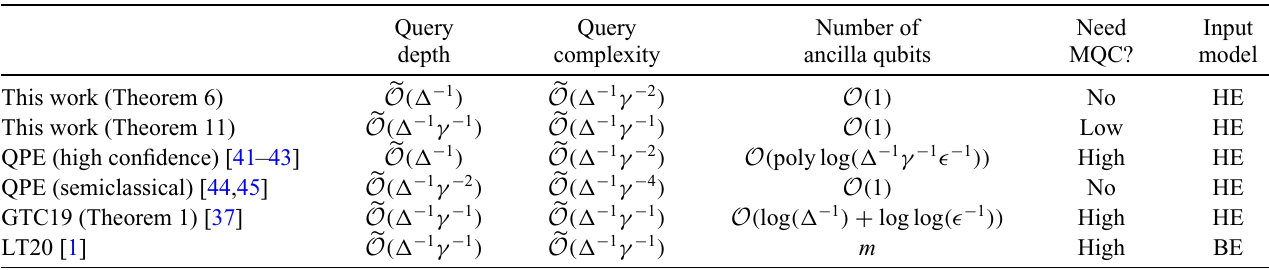
TABLE II. A comparison of the performance of quantum algorithms for ground-state preparation in terms of the query complexity, the query depth, the number of ancilla qubits, and the level of multiqubit control (abbreviated as “MQC” in the table) operations needed. γ is the overlap between the initial guess | φ 0 (cid:3) and the ground state, (cid:11) is a lower bound of the spectral gap, and 1 − (cid:4) is the target fidelity. “HE” denotes the Hamiltonian-evolution model (assuming no ancilla qubits) and “BE” the block-encoding model. Here, we assume that an upper bound of the ground-state energy is known ( μ in Theorem 6). The algorithm in Ref. [37] (GTC19 in the table) requires precise knowledge of the ground-state energy. We assume that Ref. [1] uses m ancilla qubits and that the high-level MQC operation is due to the block encoding of H .